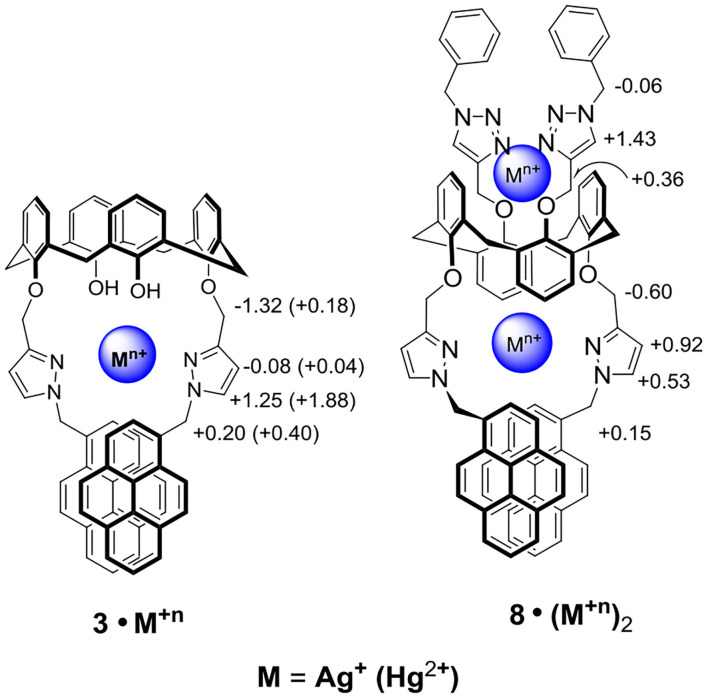
Two possible binding modes of ligands 3 and 8 with Ag+ and Hg2+ ions, where the chemical shift differences (Δδ = δcomplex – δligand) are shown for Ag+ (data for Hg+2 complexes are in parentheses).